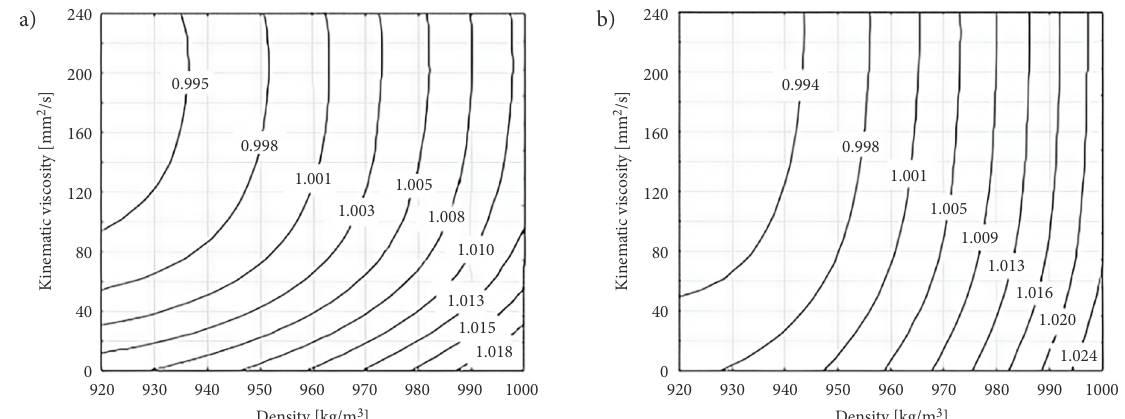
Figure 11. Multivariate characteristics of relative BSFC change in SKL VDS 48/42 engine: